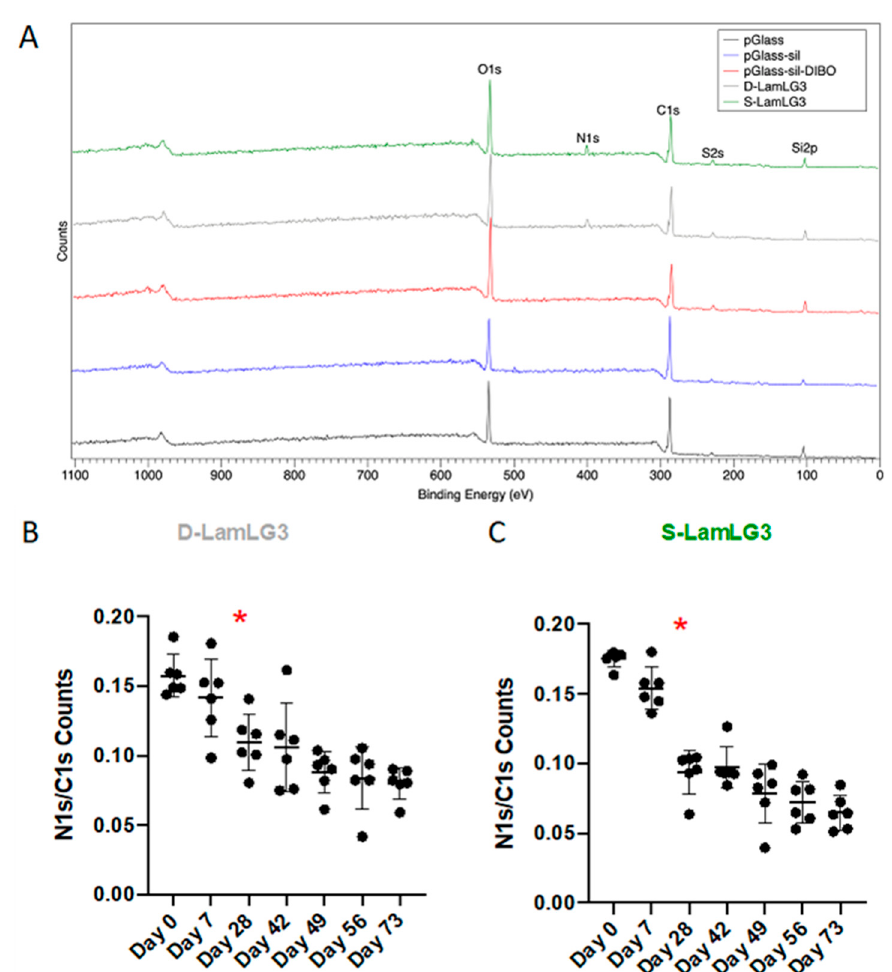
Figure 3. X-ray photoelectron spectroscopy spectra of peptide-coated (D-LamLG3, S-Lam-LG3) and non-coated, control surfaces. Full survey spectra of each coated and non-coated, control surface ( A ) and the ratio of N 1 s X-ray photoelectron spectroscopy counts to C 1 s counts (N 1 s :C 1 s ) for D-LamLG3 ( B ) and S-LamLG3 ( C ) following up to 73 days in artificial saliva (37 °C). Differences in mean between groups were assessed with a one-way analysis of variance (ANOVA) table followed by a Tukey’s HSD (honest significant difference) post hoc test. A p value <0.05 was considered statistically significant. The asterisk (*) denotes when the N 1 s /C 1 s signal was statistically significantly reduced compared to day 0.